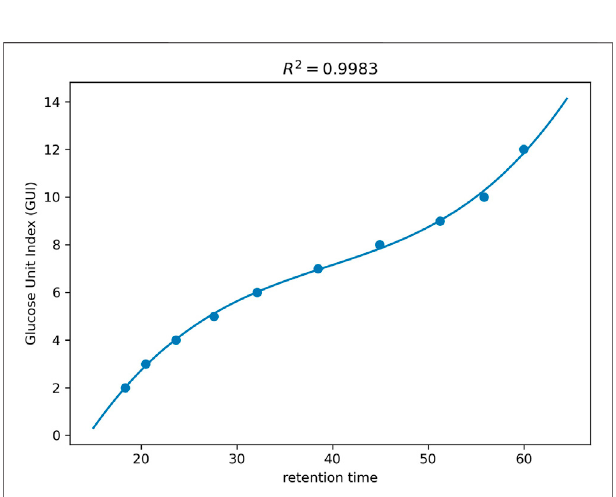
FIGURE 3 | The curve fi tting of GUI as a polynomial function of the retention time on dextrin ladders with different number of GUs.